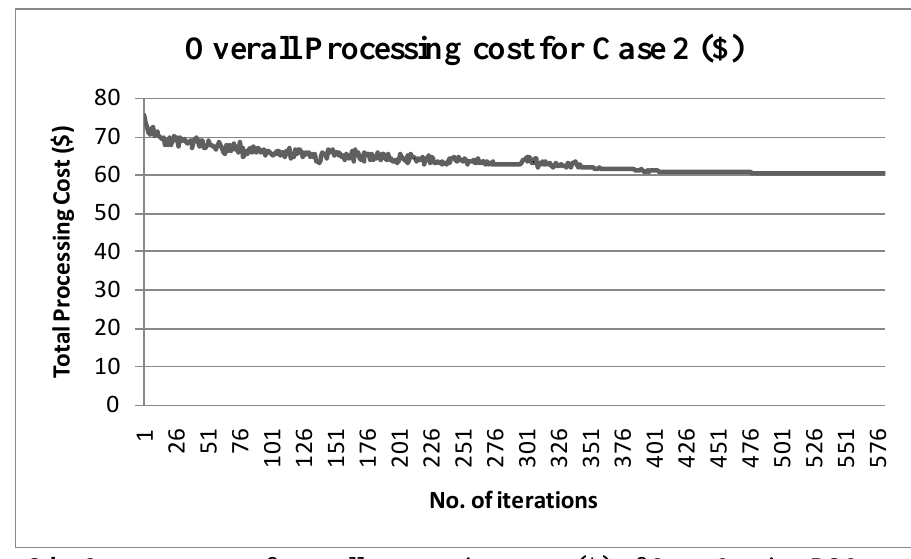
Fig. 3.b. Convergence of overall processing costs ($) of Case 2 using PSO